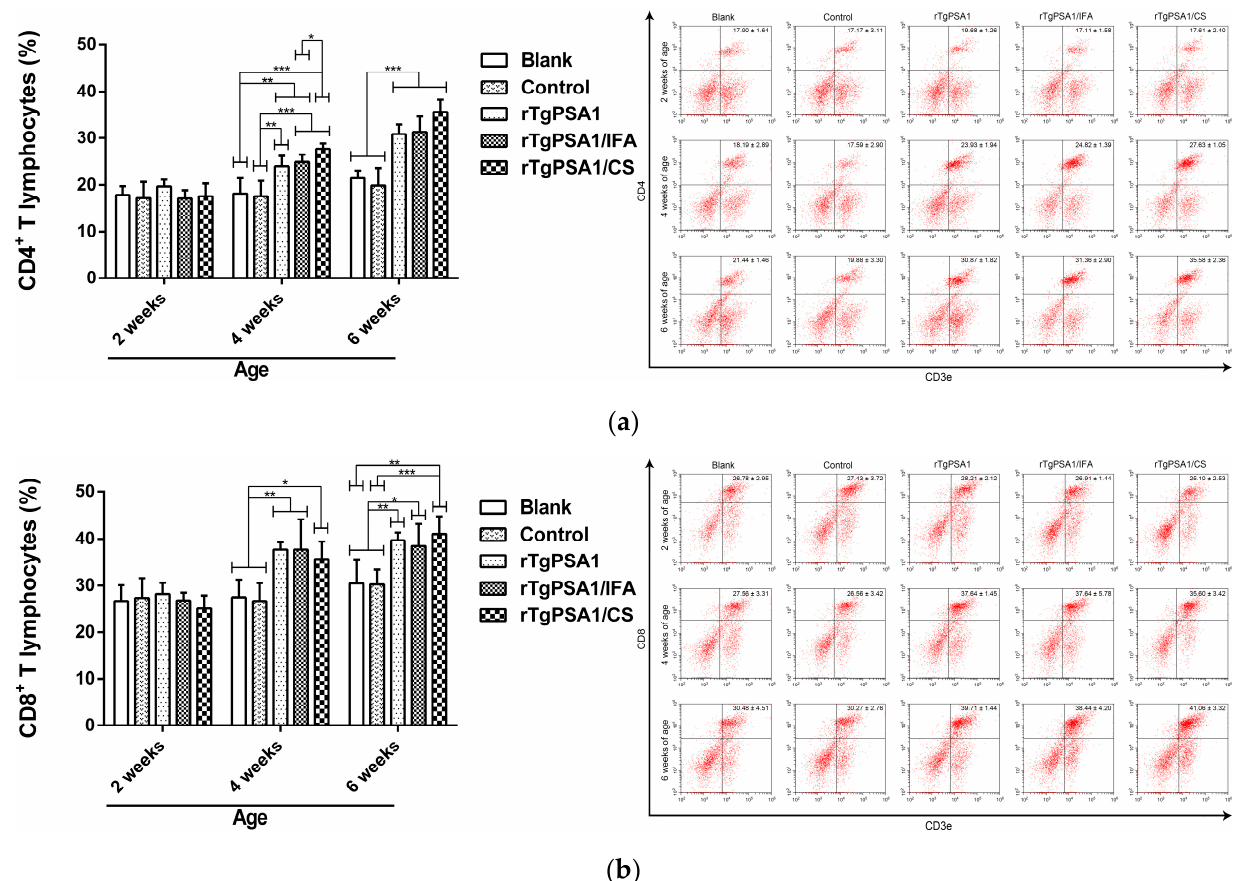
Figure 10. Flow cytometry analysis of ( a ) CD4 + and ( b ) CD8 + T lymphocytes in spleen lymphocytes at two, four, and six weeks of age. Five chickens in each group were sacrificed and spleen lymphocytes were collected. Each sample was conducted once. Results were estimated by one-way ANOVA followed by Dunnett’s test, and values are shown as mean ± SD (n = 5). Values between rTgPSA1/IFA and rTgPSA1/CS groups were compared with the independent t -test. * p < 0.05, ** p < 0.01, and *** p < 0.001 compared with blank or control